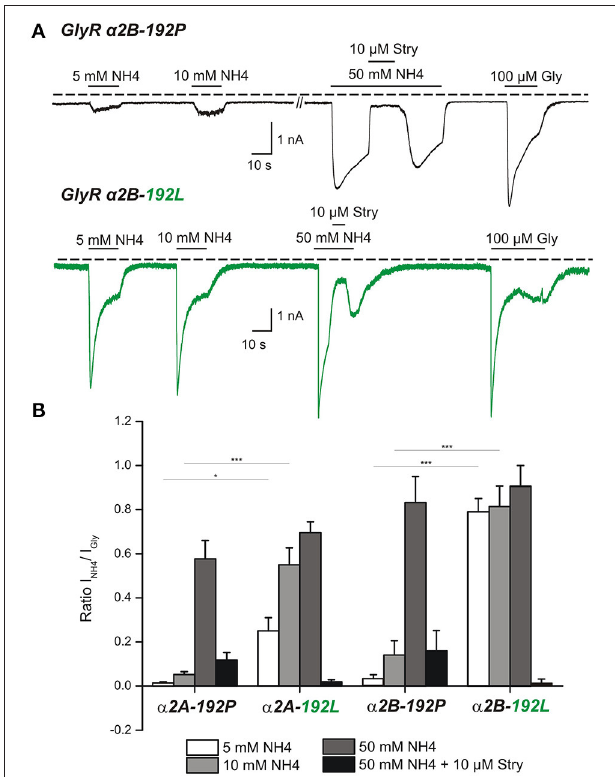
FIGURE 5 | Whole cell patch clamp analysis of transfected HEK293T cells reveals the potential of NH 4 to activate RNA-edited, not the non-edited, GlyR α 2 at physiological concentrations. (A) HEK293T cells were transfected with non-edited GlyR α 2 (192P, upper panel) or C-to-U RNA-edited GlyR α 2 (192L, lower panel). Traces of electrophysiological recordings show NH 4 dose-dependent effects on GlyR currents. Note that 5 and 10mM NH 4 resulted in significantly stronger activation of RNA-edited GlyR α 2 compared to non-edited GlyR α 2. At a concentration of 50mM NH 4 both types of receptors were comparably activated. Currents could be blocked with 10 µ M strychnine (Stry). For normalization, current responses to 100 µ M glycine were acquired in the same cells. (B) Quantification of NH 4 -elicited currents relative to currents elicited with 100 µ M glycine. Asterisks mark significant differences (* P <